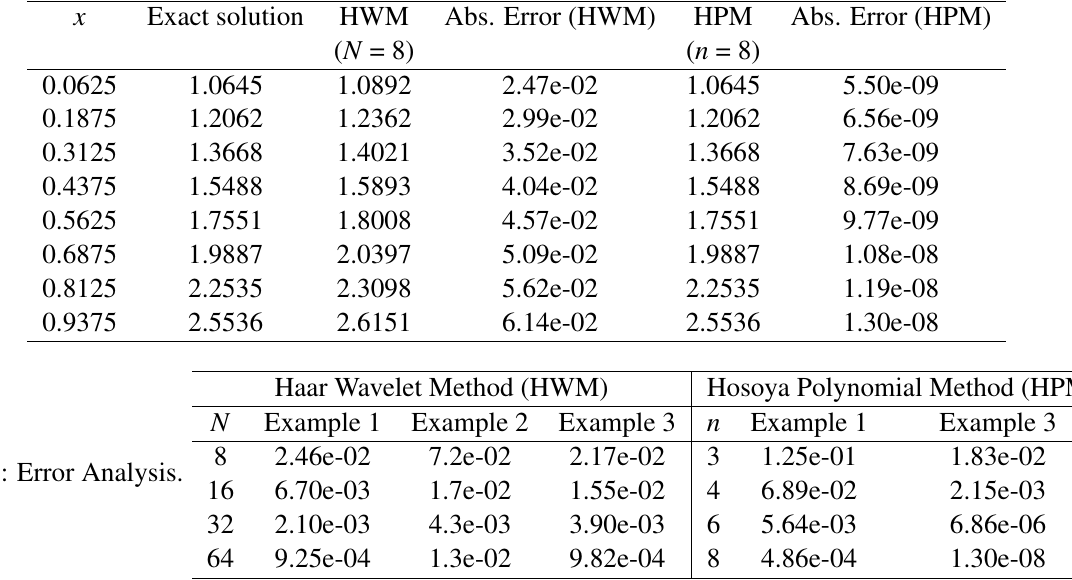
Table 2: Numerical result of Example 3.